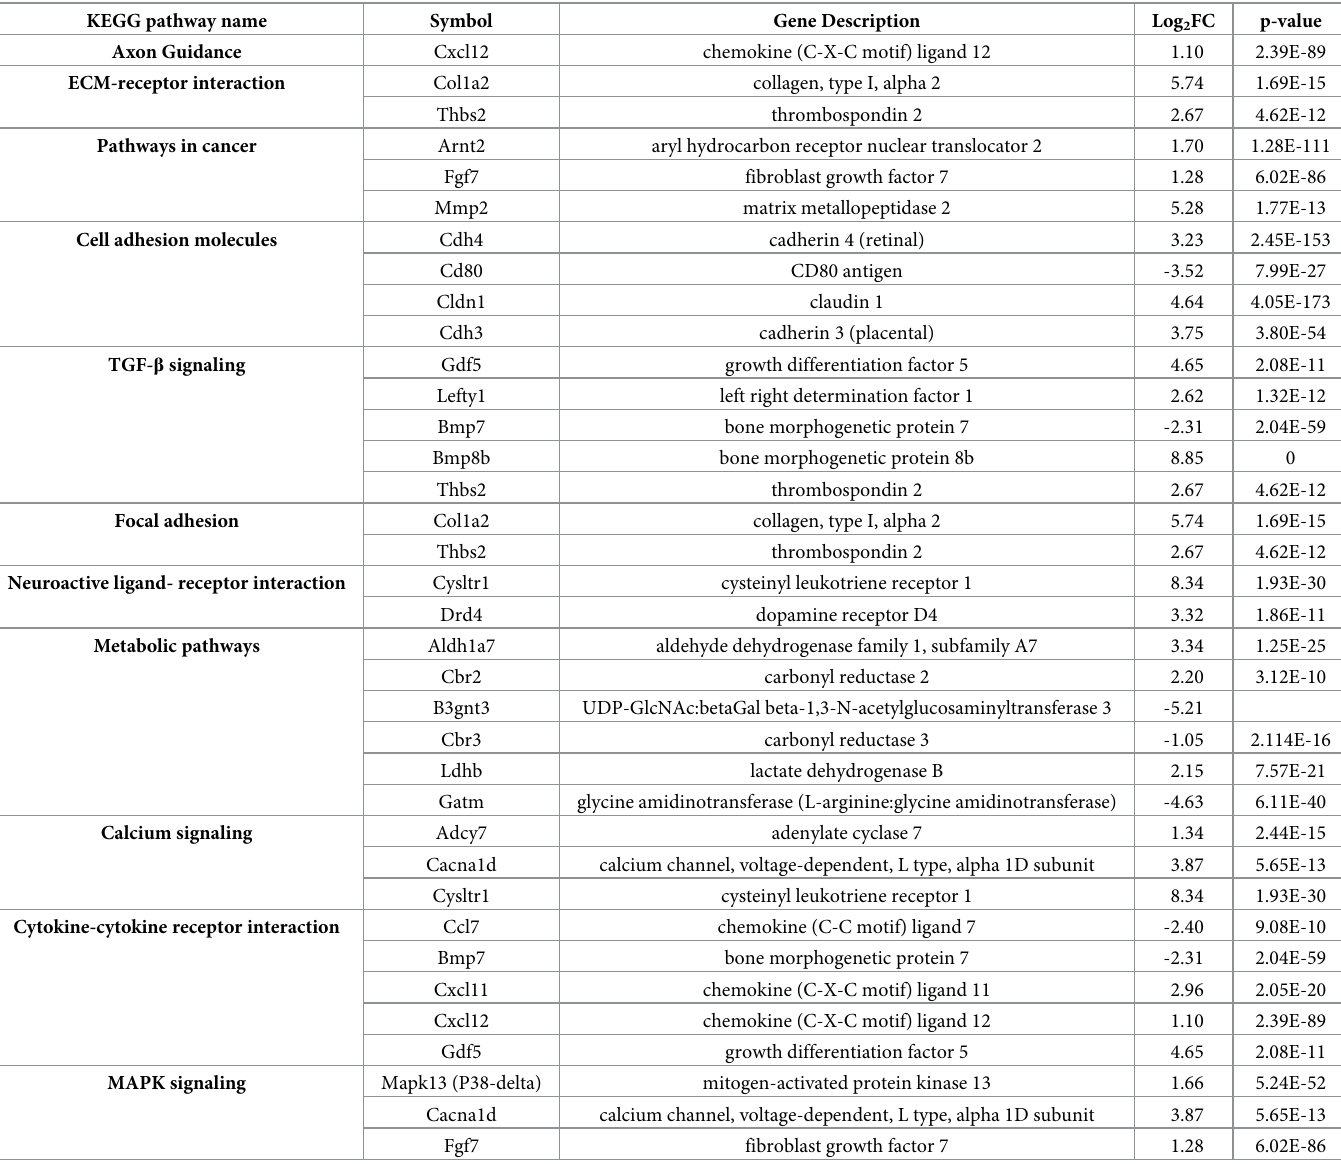
Table 3. Differentially expressed gene selected for RT-qPCR